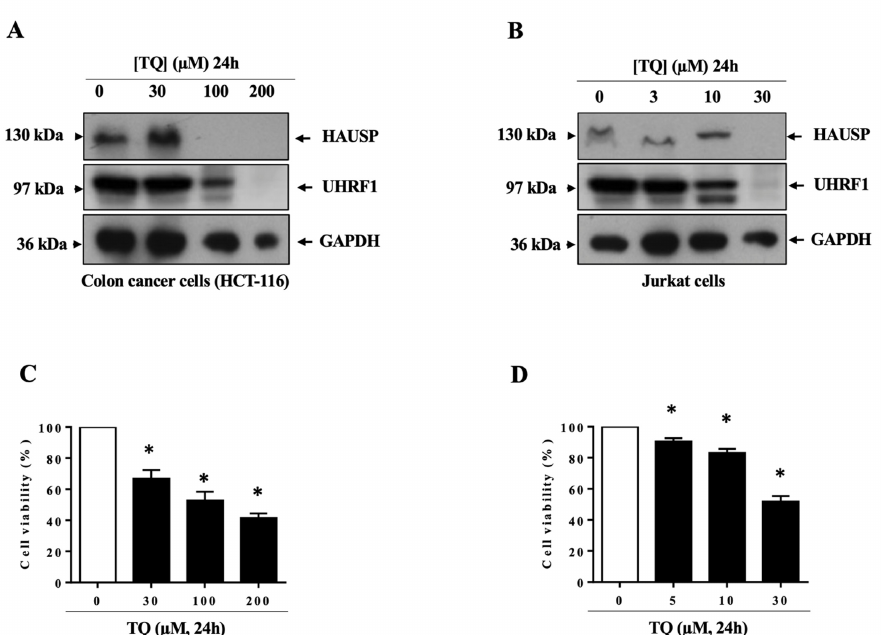
Figure 1. Dose-dependent effect of TQ on the protein expression of HAUSP and UHRF1 and cell proliferation. Human colon cancer (HCT-116) ( A , C ) and Jurkat cells ( B , D ) were exposed to increasing concentrations of TQ for 24 h. The expression of HAUSP and UHRF1 was analyzed by means of Western blotting, as described in the Materials and Methods. The cell proliferation rate was assessed via the WST-1 assay. Values are shown as means ± S.E.M of three different experiments. * p < 0.05 versus control.